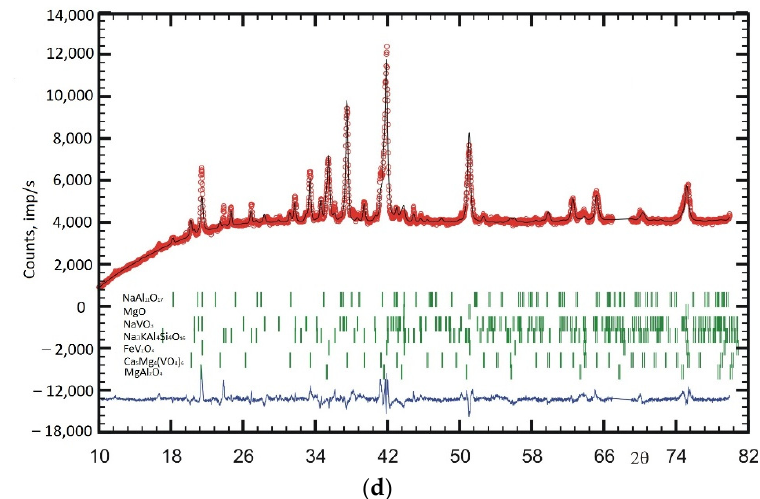
Figure 2. Experimental (red), theoretical (black), and differential (blue) diffractograms acquired from deposits on the electrode ( a ) and slag samples #1 ( b ), #2 ( c ), and #3 ( d ). Green dashes correspond to the positions of reference diffraction peaks of correspondent phases. Table 4. The quantitative phase composition of slag and deposits on the electrode, %wt.